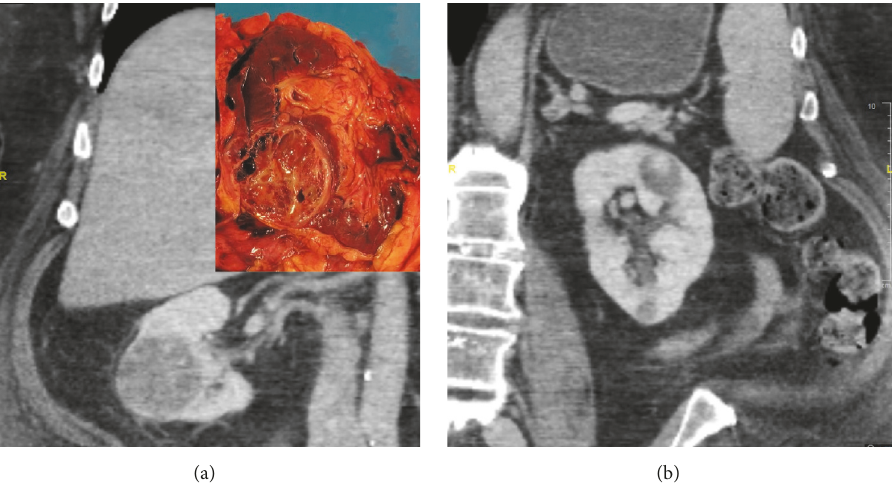
Figure 1: Axial CT images of the (a) right kidney with the largest mid-kidney mass and corresponding gross image [inset] and (b) left kidney with largest upper pole mass.